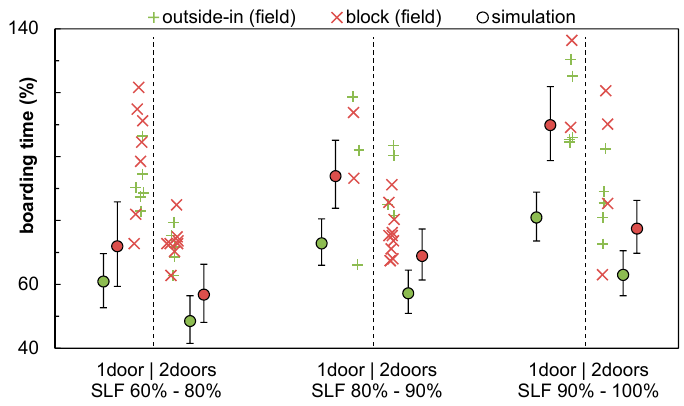
Figure 16. Comparison of simulation results and measured boarding times using the block strategy (validation Scenario S1 ) and the standard outside-in boarding strategy.